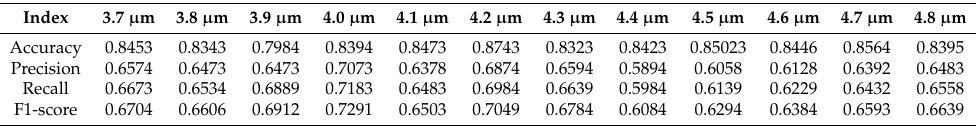
Table 4. Accuracy, precision, recall, and F1-score results of the coded mask images of different wavelengths.